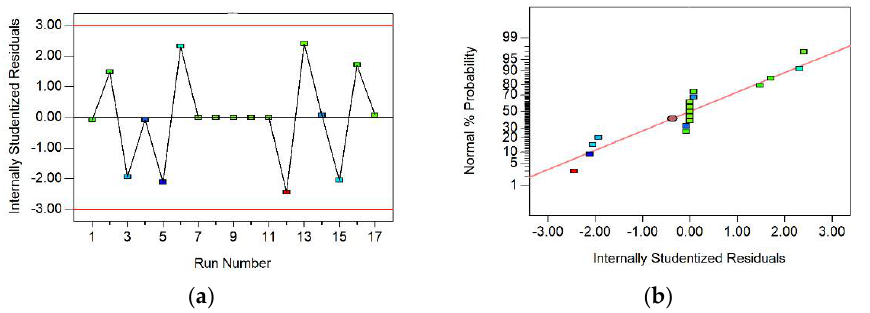
Figure 5. Residual distribution diagram of the response variable. ( a ) Internally studentized residu- als vs. run number (The red line is the residual range line). ( b ) Normal probability vs. internally studentized residuals (The red line is the residual regression line).